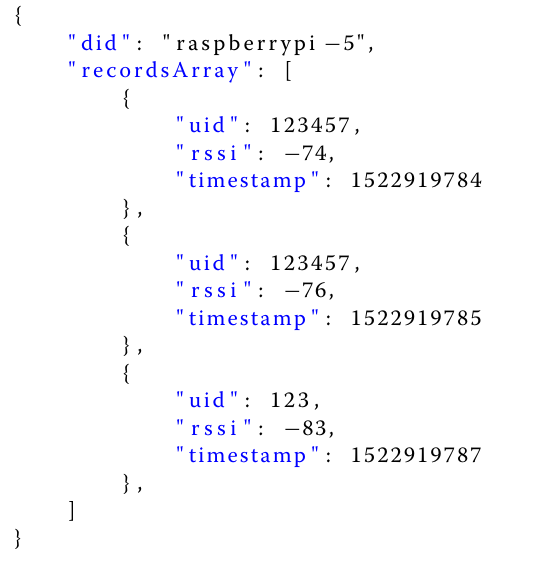
The Filter pulls the data from the Aggregator, orders them based on their uid and timestamp and pushes the new structures to the Load Balancer. It uses standard HTTPS requests towards the Aggregator and exposes a websocket interface towards the Load Balancer.